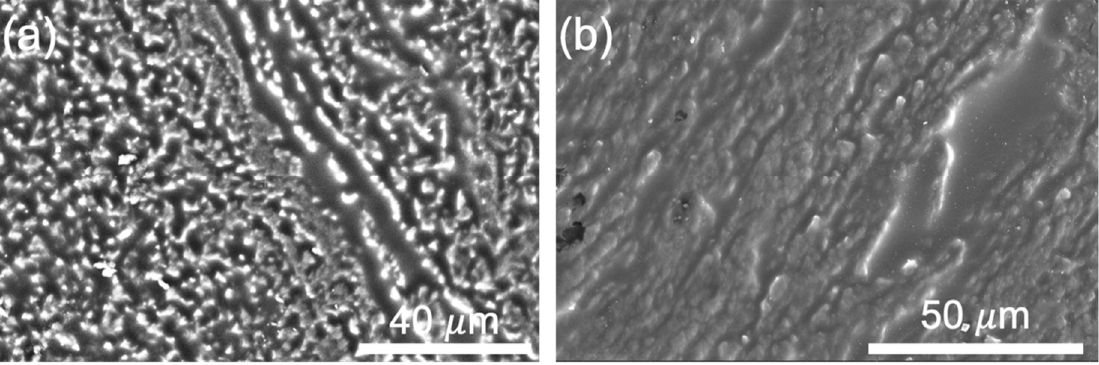
Figure 4. SEM images of the CNT-NEE: ( a ) untreated thin film after microtoming and ( b ) film after plasma treatment for 60 s at 1000× magnification.